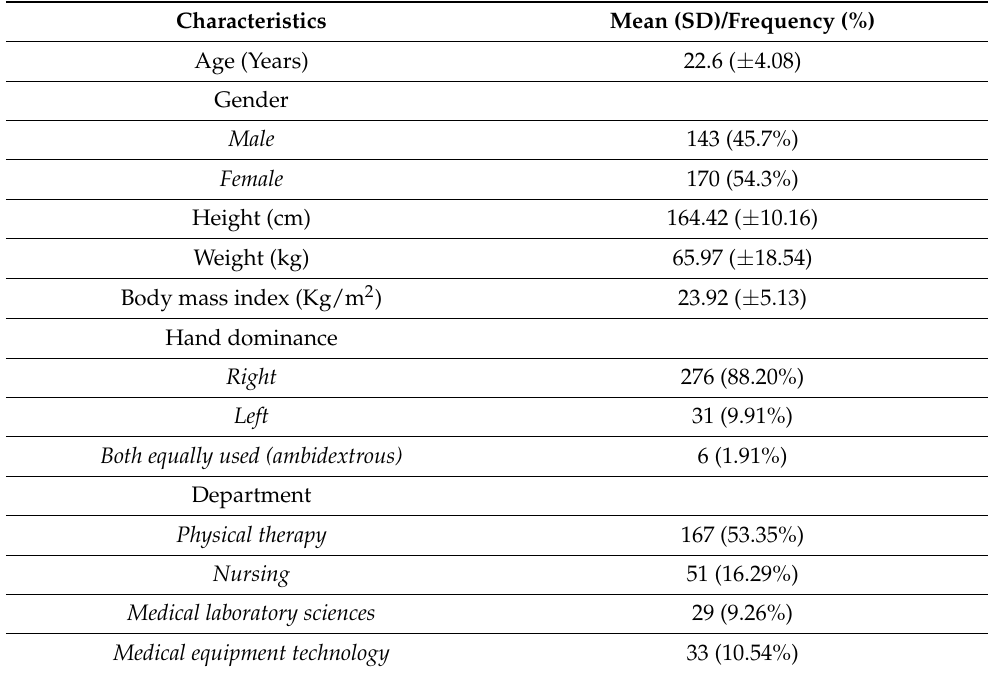
Table 1. Socio-demographic